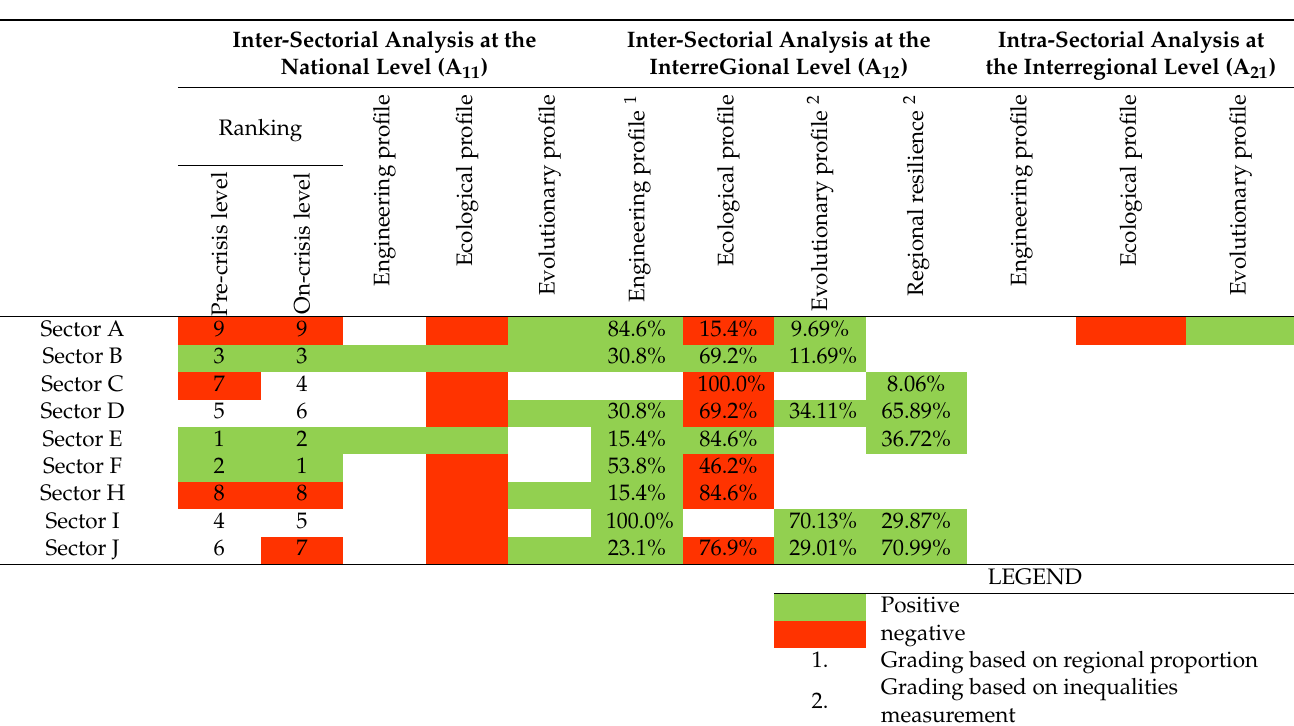
Table 4. Summary table with the resilience profiles extracted from the inter-sectorial and intra- sectorial